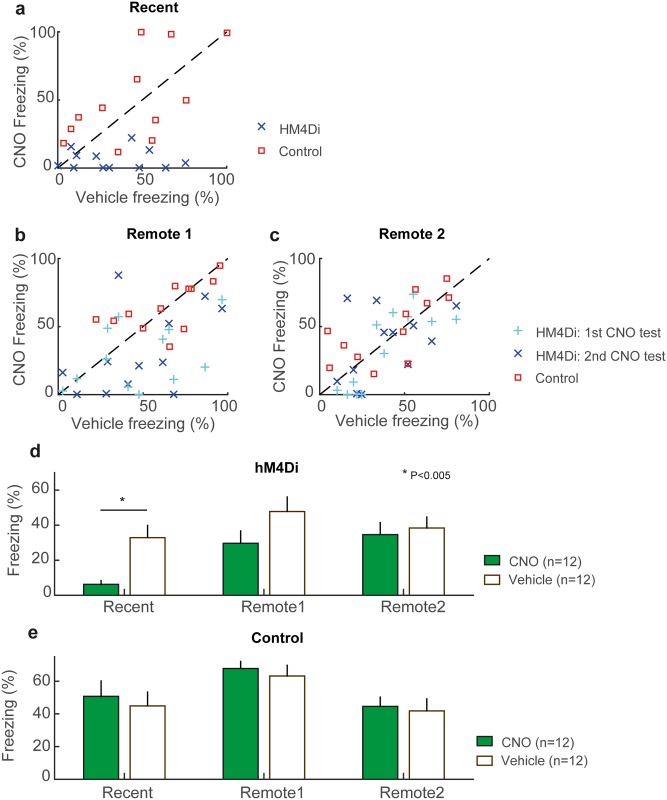
Testing the hippocampus dependence of recent and remote memories.a-c: Comparison of freezing levels (post-CNO and post-Vehicle injection) in the (a) recent memory test, (b) remote 1 memory test, (c) remote 2 memory test, for control mice (n = 12, red) and hM4Di mice (n = 12, blue, cyan). d-e: Freezing levels following CNO (filled bars) and Vehicle (unfilled bars) injections for the Recent, Remote 1 and Remote 2 memory test in (d) hM4Di mice and (e) control mice. (* P<0.005, Signed rank test). For the Remote 1 and Remote 2 tests, the mean CNO freezing level (across two successive tests) is plotted).